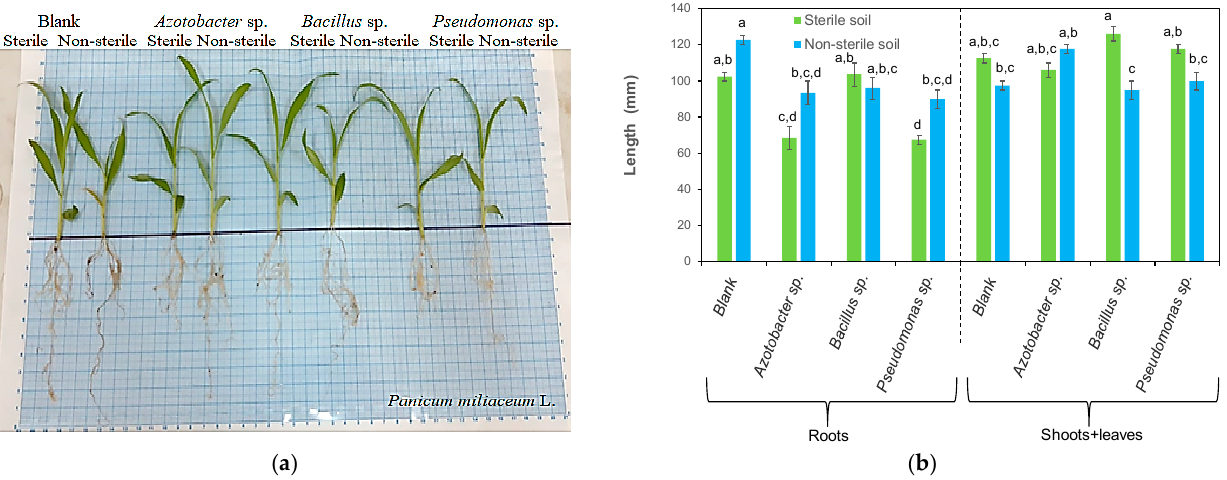
Figure 6. Effects of Azotobacter , Bacillus and Pseudomonas species on Panicum miliaceum L.: ( a ) visual aspect of plants and ( b ) the root and shoot/leaf length (error bars represent the experimental error; means that do not share a letter are significantly different according to the Tukey’s HSD test).